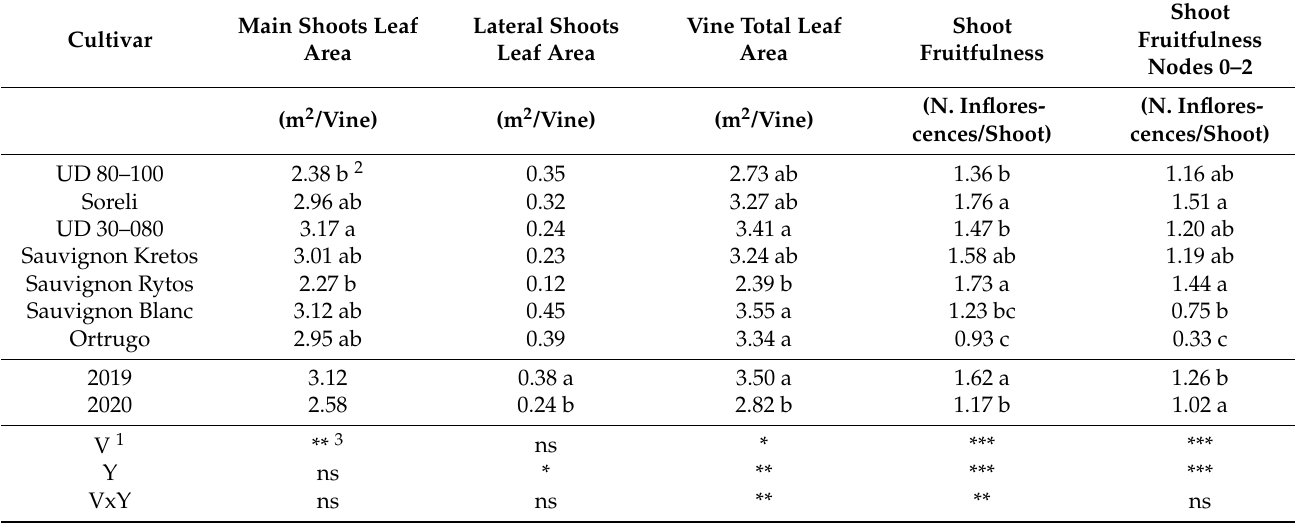
Table 2. Vegetative growth and shoot fruitfulness of five pathogen-resistant grapevine genotypes and two non-resistant Vitis vinifera cultivars in 2019 and